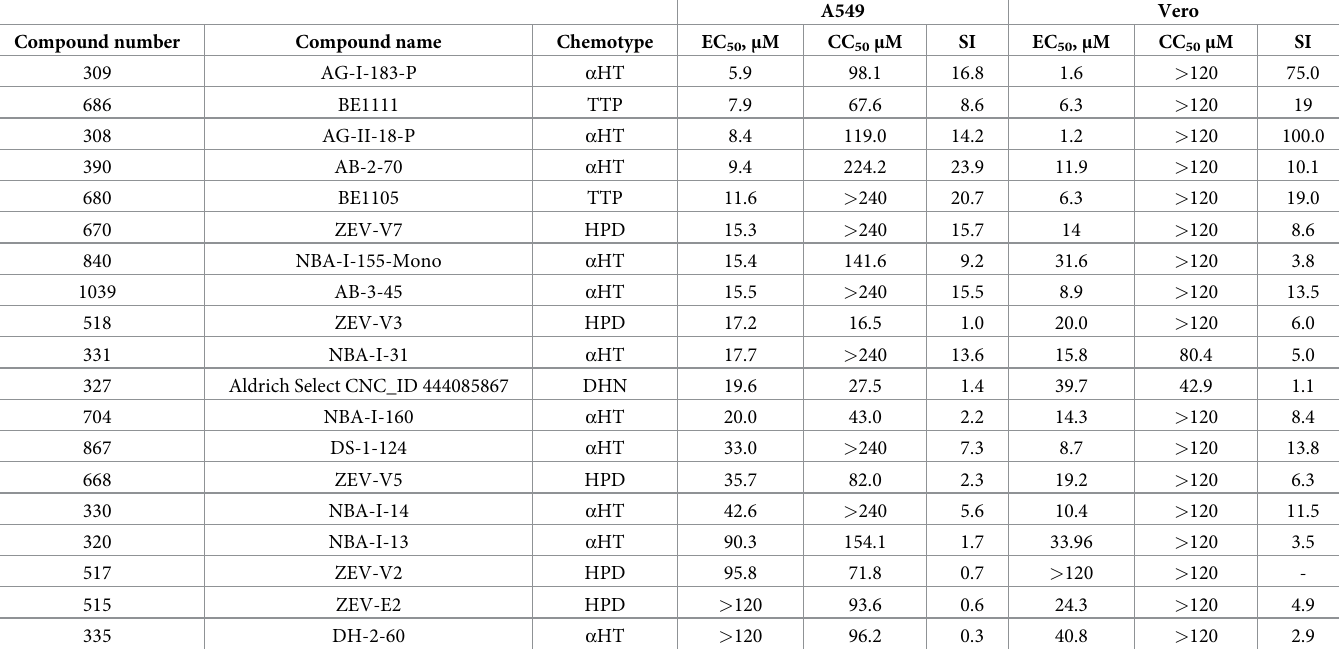
Table 2. EC 50 against RVFV